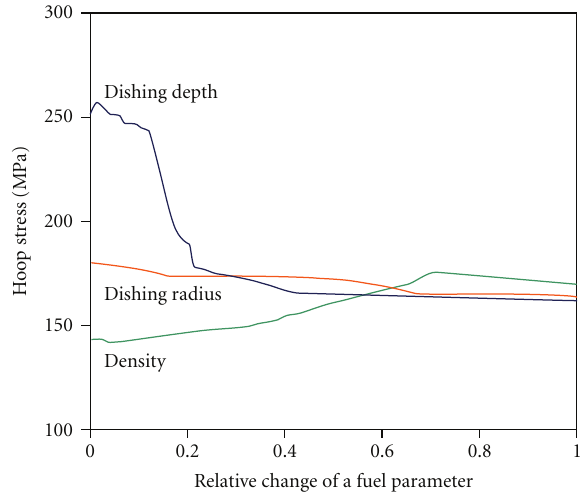
Figure 7: Hoop stress parametric analysis. Analyze of the relative influence of fuel parameters during the first reshu ffl ing of a fuel element irradiated in the Atucha I